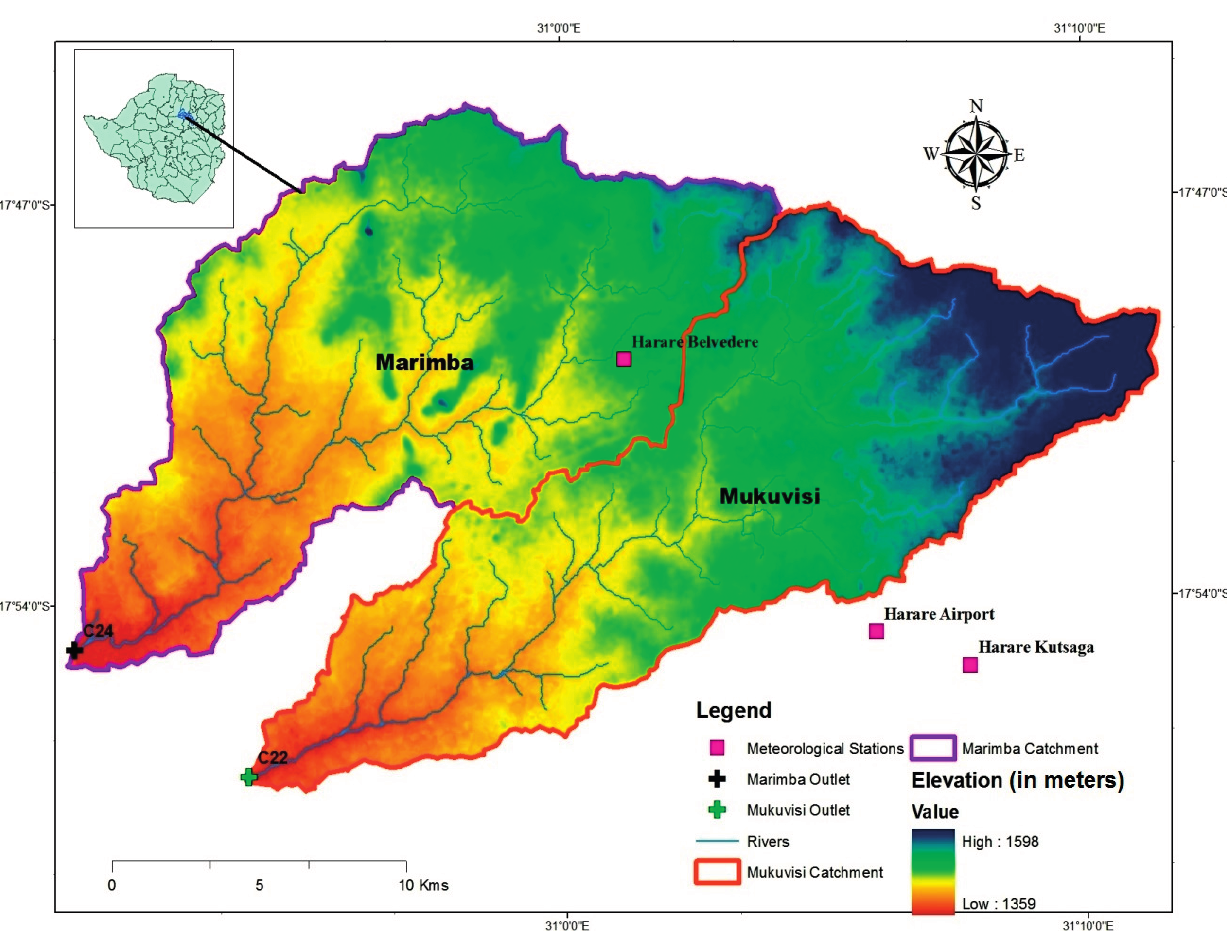
Figure 1. Mukuvisi and Marimba catchments in Zimbabwe showing elevation and locations of meteorological stations and streamflow gauging